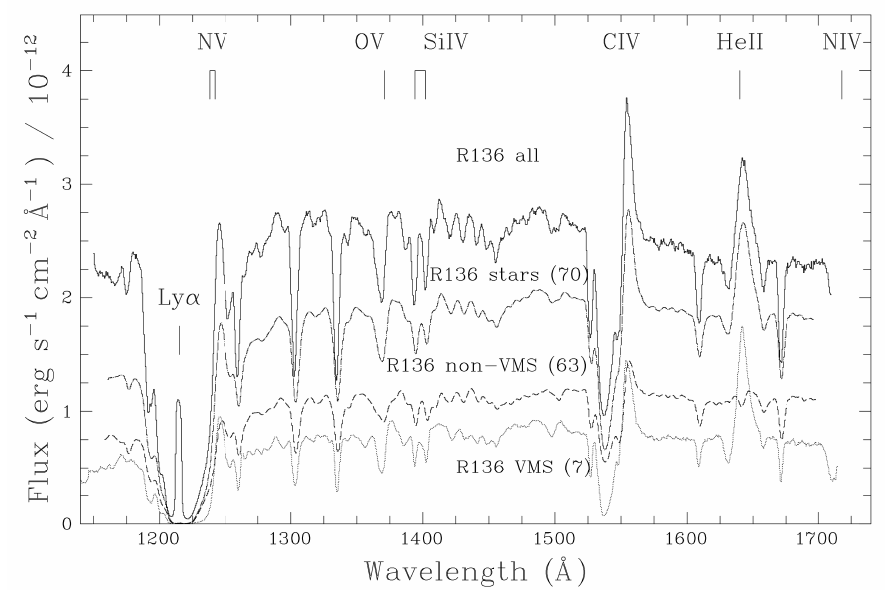
Figure 3. Integrated HST spectrum of all sources within 0.5 parsec of R136a1 (solid, all stars), the composite spectrum of all 70 bright stars with F 1500 ≥ 5 × 10 − 15 ergs − 1 cm − 2 Å − 1 (dot-dash), comprising 7 very massive stars (VMS, dotted), and the remaining 63 far-UV bright stars (dashed). He II λ 1640 emission in R136 is totally dominated by VMS. The difference between the ‘stars’ and ‘all’ arises from the contribution from UV-faint, late-type O stars and unresolved early B stars. From